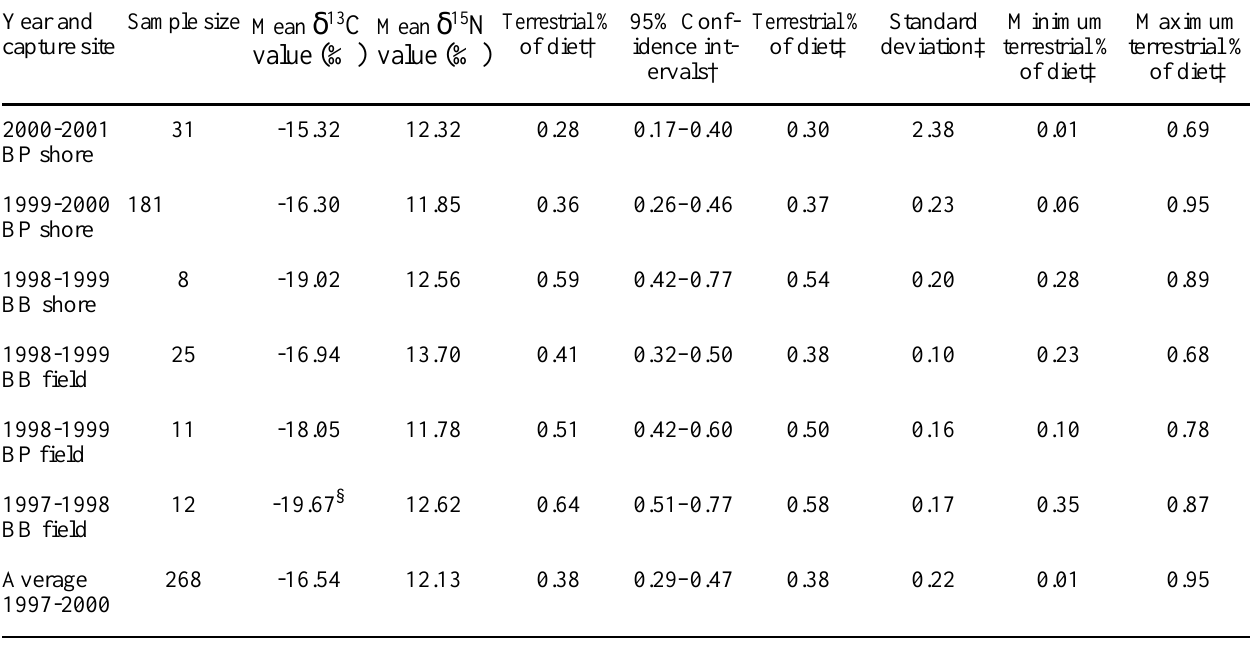
Table 2 . Proportions of Dunlin diet from terrestrial and estuarine sources as calculated with the two-isotope and single-isotope mixing